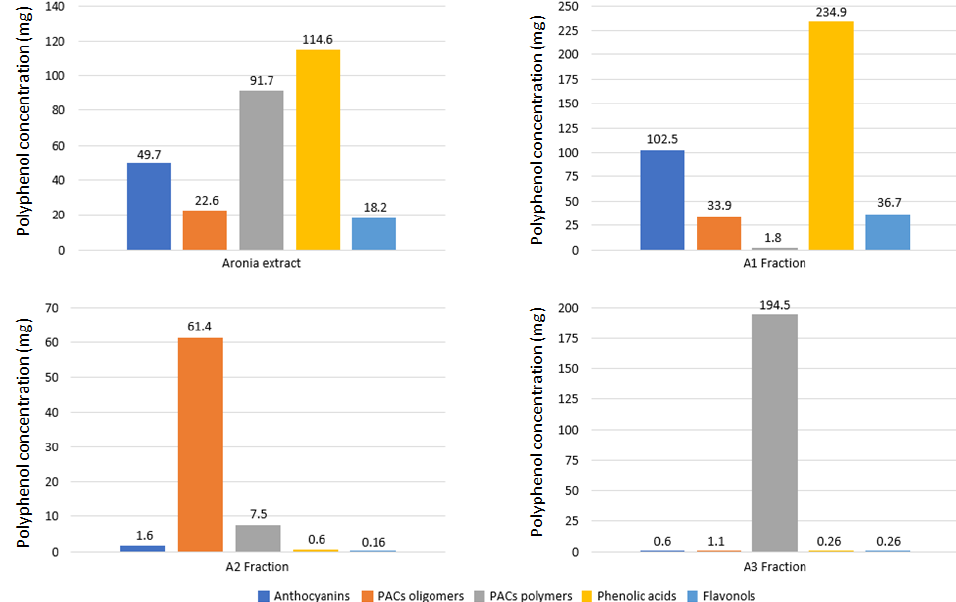
Figure 1. Polyphenolic characterization of AE and the three polyphenolic fractions (A1, A2, and A3). Values are expressed in milligrams of polyphenols per gram of extract or fraction. Taken together, the three fractions obtained from the fractionation of AE showed a very different polyphenolic composition. The A1 fraction was mainly composed of phenolic acids and anthocyanins with some flavonols, whereas the two PAC fractions were almost pure PAC fractions with oligomers and polymers for A2 and A3 fractions,